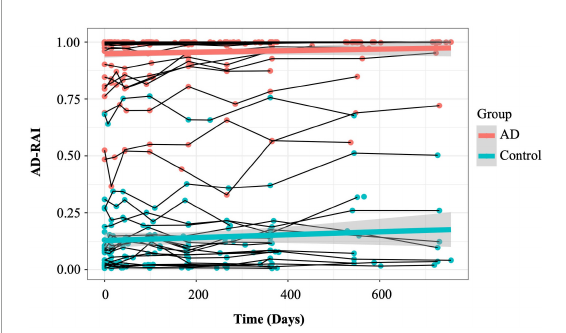
FIGURE3 Longitudinal trajectories of AD-RAI in AD patients and controls. The thin lines connecting the dots represent the trajectories of AD-RAI of individual participants over time. The thick green and red lines represent the average trajectory of AD-RAI over time in control and AD groups, respectively. AD, Alzheimer’s disease; AD-RAI, Alzheimer’s disease-resemblance atrophy